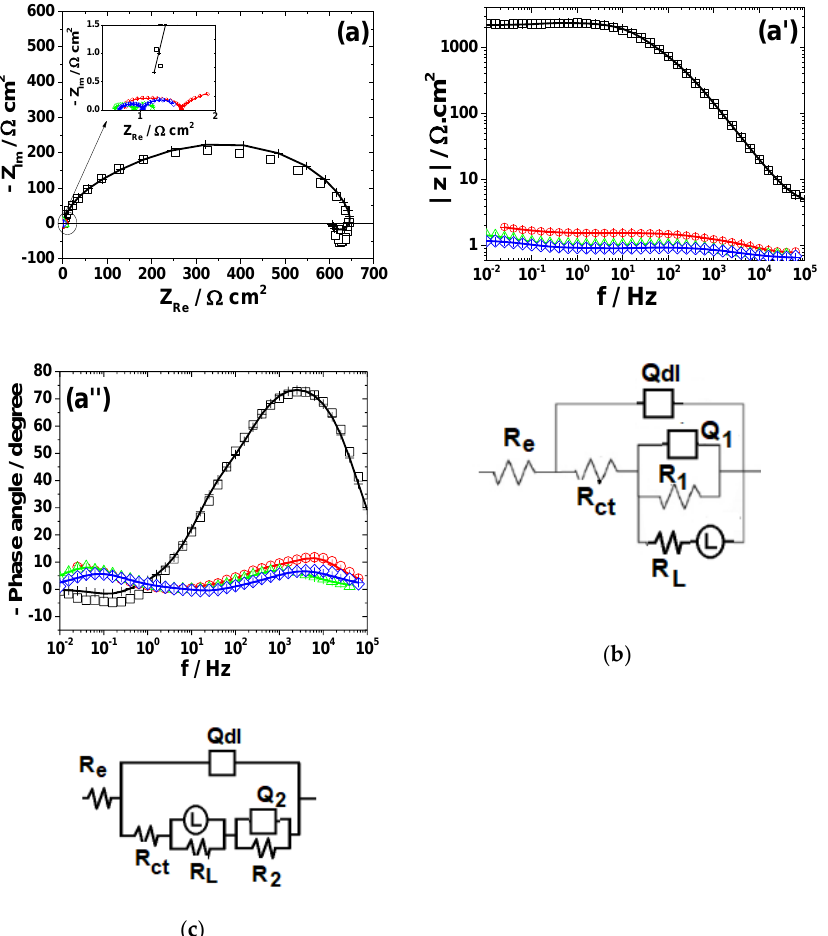
Figure 4. EIS results of Zn after immersion in different bromide-based electrolytes: Nyquist diagrams ( a ); Bode plot of |Z| vs. frequency ( a’ ); and Bode plot of phase angle vs. frequency ( a” ). The equivalent electrical circuits used for EIS fitting ( b , c ). Symbols represent the experimental data and lines with cross (—+—) correspond to the simulated spectra. Electrolytes: (□) Sol. A; (O) Sol. B; (◊) Sol. C; and (Δ) Sol. D.